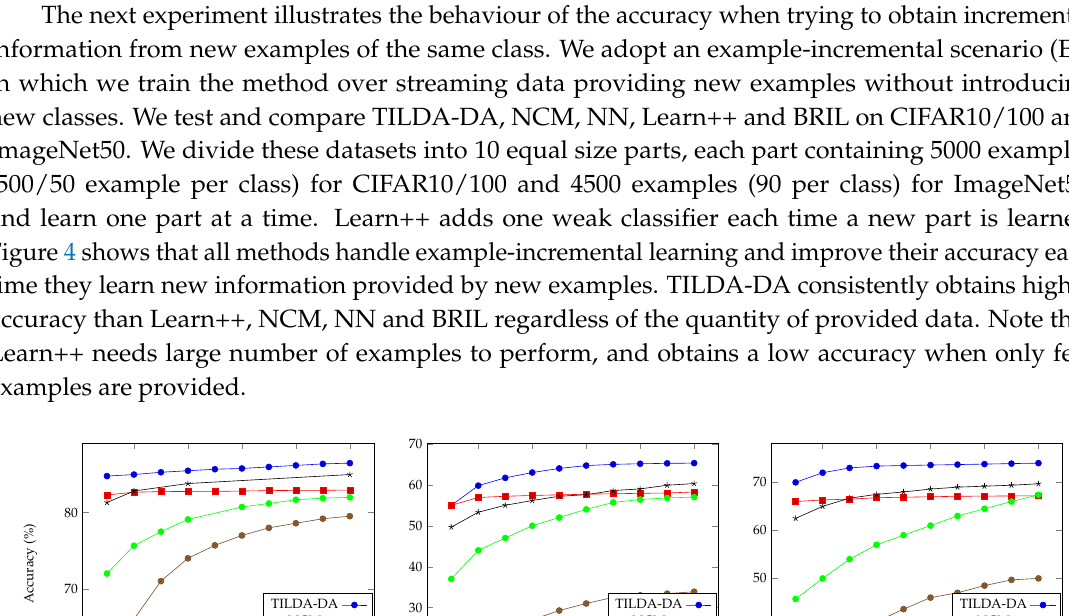
Figure 3. Evolution of the accuracy as a function of number of classes for CIFAR10 ( left ), CIFAR100 ( middle ) and ImageNet50 ( right ).